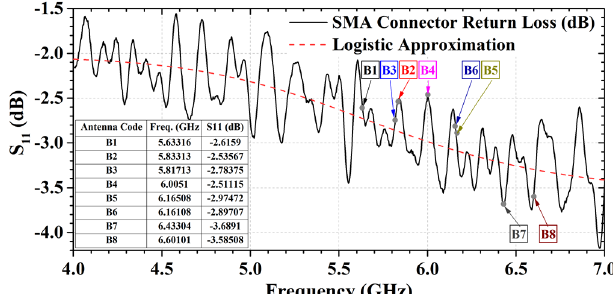
Figure. 8. The magnitude of measured S 11 without any EM load.